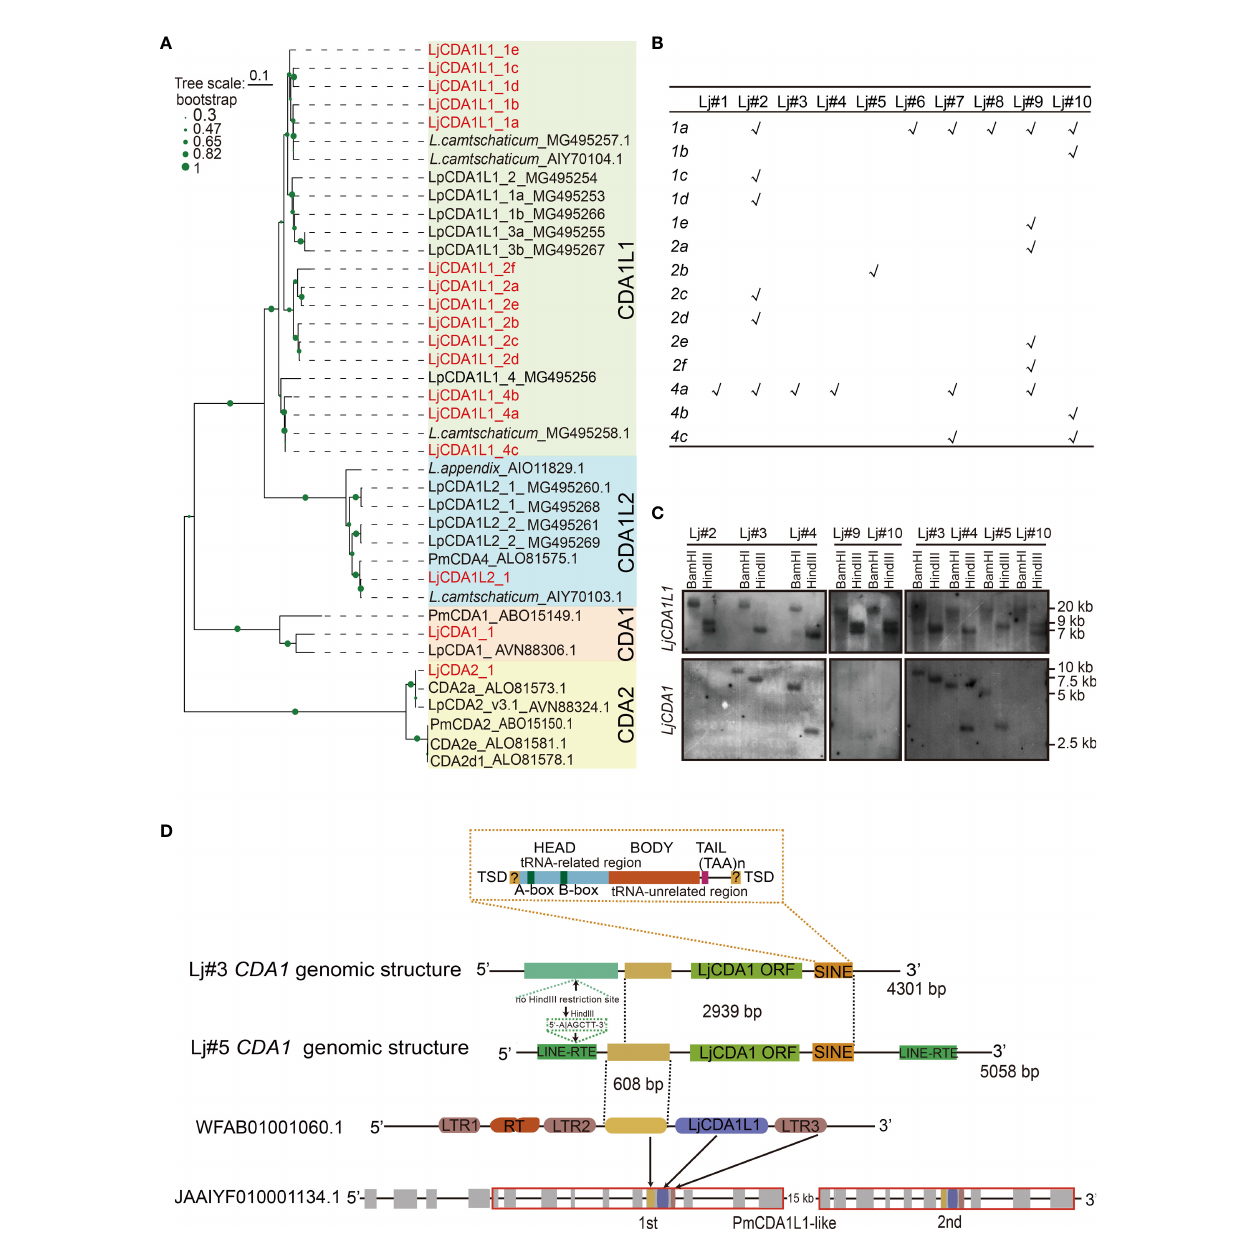
FIGURE 1 | Expansion and genetic exclusion of LjCDA1 and LjCDA1L1 . (A) Neighbor-joining tree of lamprey AID/APOBEC deaminases. The amino acid sequences of the core region of the cytidine deaminases (CDAs) were aligned using CLUSTALW. Alignments were manually adjusted based on secondary structure predictions. A neighbor- joining tree was calculated using MEGA version 5.05 with 1,000 bootstrap replications. Colored boxes represent distinct lamprey AID/APOBEC deaminases. Species abbreviation: Lj, Lethenteron japonicum ; Pm, Petromyzon marinus ; Lp, Lampetra planeri. More details are shown in Figure S1 . (B) Distributions of LjCDA1L1s in distinct lamprey individuals tested by PCR. Lj#1 – Lj#10 indicate 10 distinct individuals. 1a – 4c indicate 14 distinct LjCDA1L1 genes. (C) Southern blot analyses of LjCDA1L1 and LjCDA1 genes. Genomic DNAs were digested by indicated enzymes before transferring to the Hybond N + nylon membrane. Lj#2 – Lj#5, Lj#9, and Lj#10 indicate the individual numbers of Japanese lamprey. (D) Genomic organization of lamprey LjCDA1 gene. SINE, short interspersed nuclear elements. WFAB01001060.1: fragment ID of lamprey L. camtschaticum ; JAAIYF010001134.1: fragment ID of lamprey Petromyzon marinus . RT, reverse transcriptase; LTR1 – LTR3, element of LTR